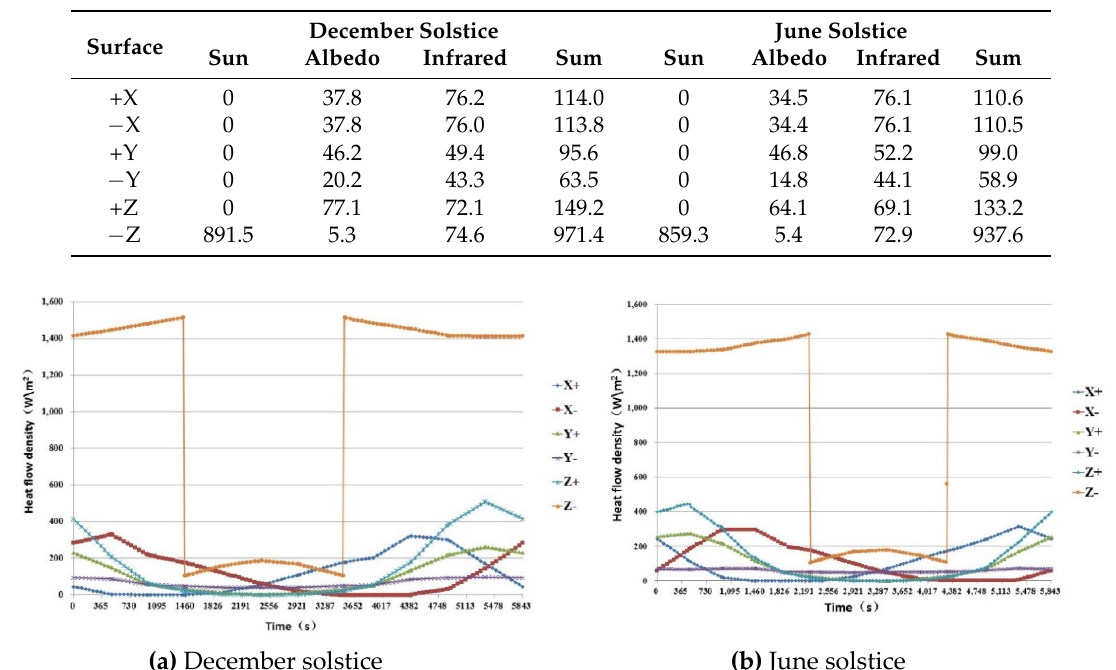
Table 7. Average heat flux density (W/m 2 ).